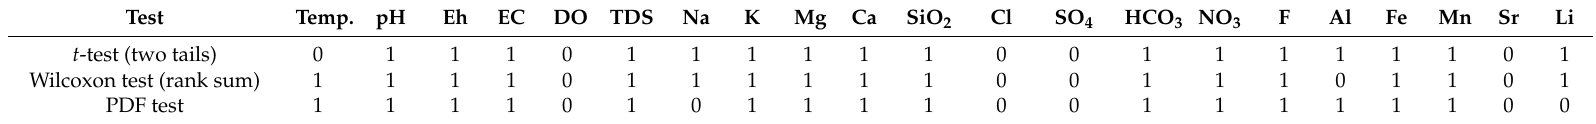
Table 8. Result of comparing PDF test with t -test and Wilcoxon test in Gyeongsang Province (0 means acceptance = no difference; 1 means rejection =